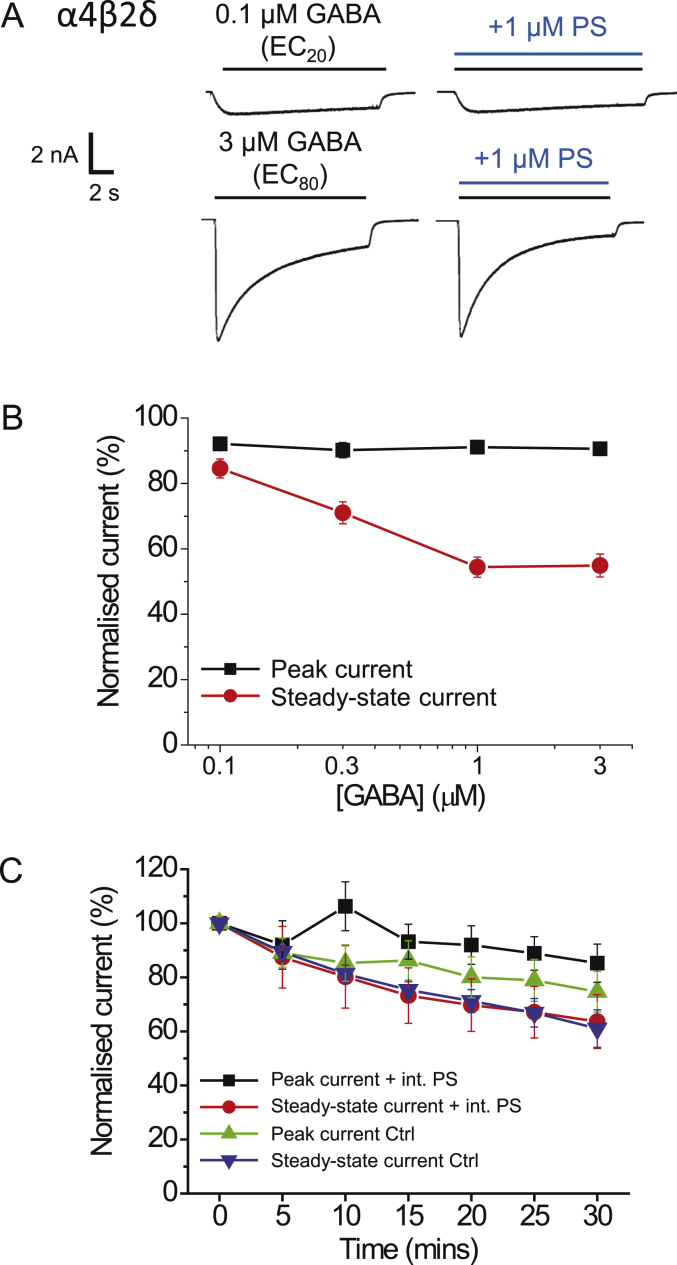
PS inhibition at δ subunit-containing GABAARs and exclusion of intracellular binding pathway.(A) EC20 and EC80 GABA-activated currents recorded from α4β2δ receptors show the effect of co-applying 1 μM PS with increasing concentrations of GABA (0.1 or 3 μM) to determine if the inhibition of α4β2δ GABA currents is activation-dependent. (B) GABA concentration profile for PS block of peak and steady-state currents at α4β2δ receptors. PS (1 μM) inhibition was increased by higher GABA concentrations (n = 6). (C) Time profiles for 1 mM peak and steady-state GABA currents at α1β2γ2L receptors applied at 5 min intervals in the absence (Ctrl) or presence (+int. PS) of 100 μM PS applied internally via the patch pipette solution (n = 7–8).